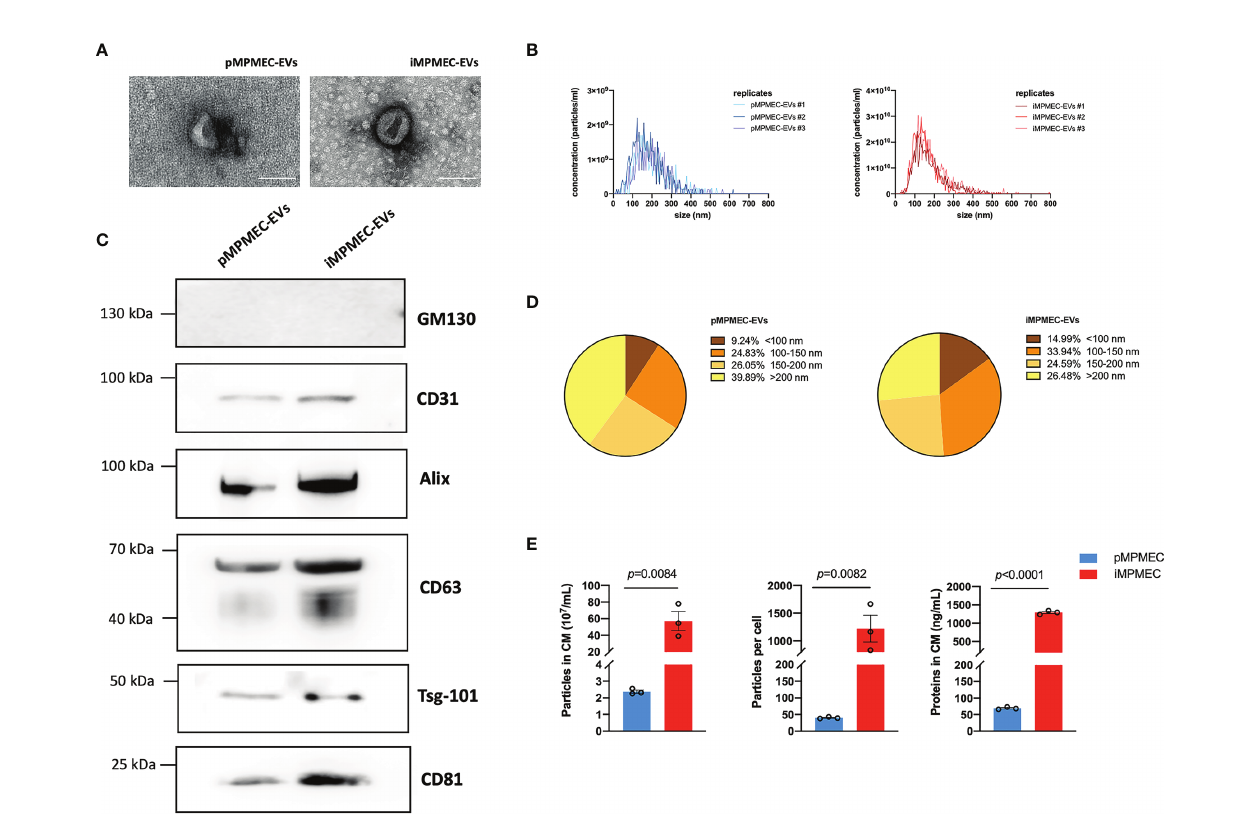
FIGURE 8 | Generation and characterization of extracellular vesicles (EVs) secreted by primary mouse pulmonary microvascular endothelial cells (pMPMECs) and immortalized mouse pulmonary microvascular endothelial cells (iMPMECs). (A) Transmission electron microscopic images of EVs secreted by pMPMECs and iMPMECs. Scale bar, 200 nm. (B) Nanoparticle tracking analysis to show the size distribution and concentration, n = 3. (C) Western blotting analysis to show the positive and negative biomarkers of EVs. CD31 is used as a positive control of EVs derived from endothelial cells. (D, E) Quanti fi cation of EVs derived from pMPMECs and iMPMECs, n = 3. p -values are determined by Student ’ s t